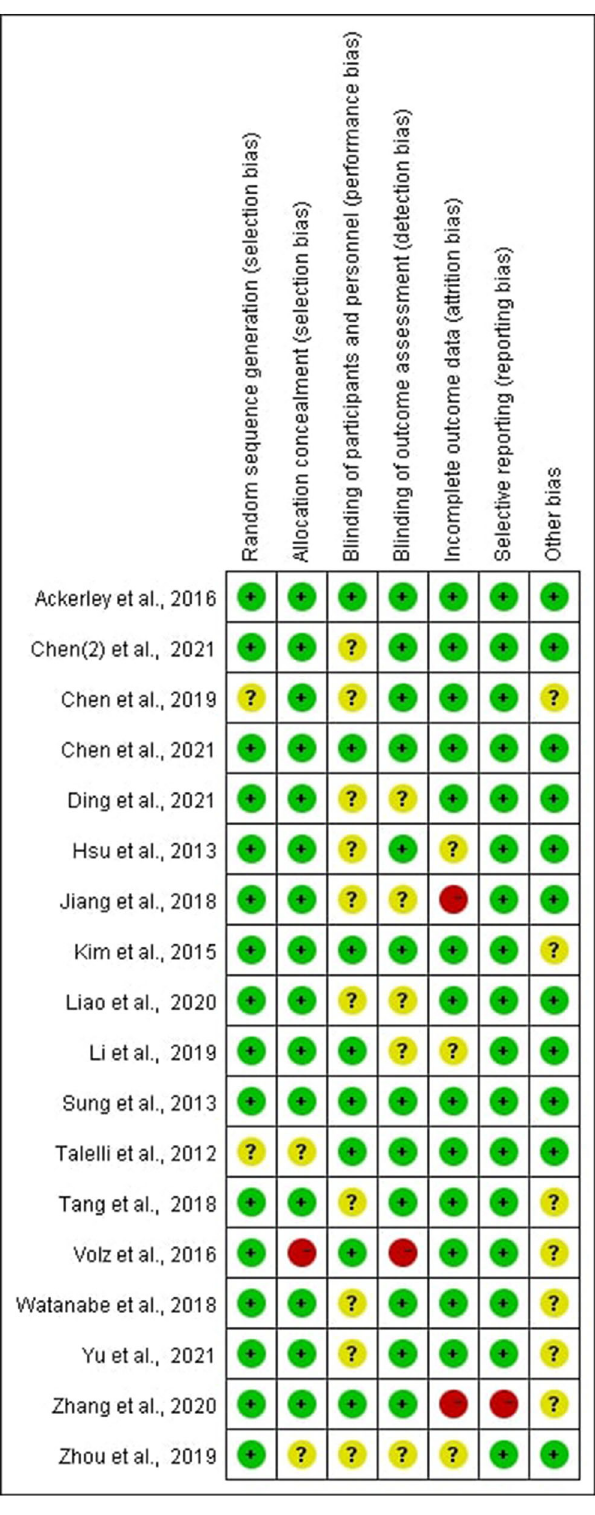
FIGURE 3 | Risk of bias